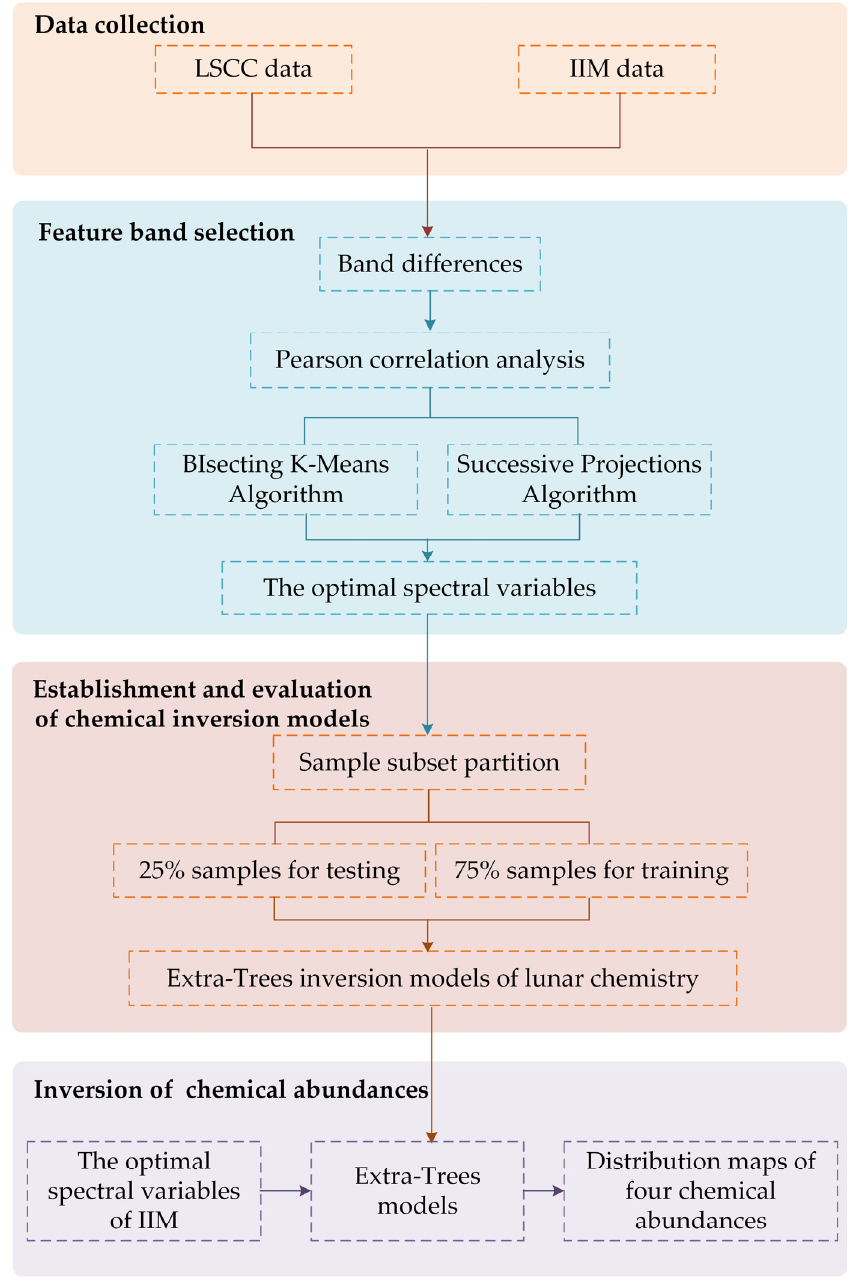
Figure 1. Flow chart of lunar surface chemical inversion.